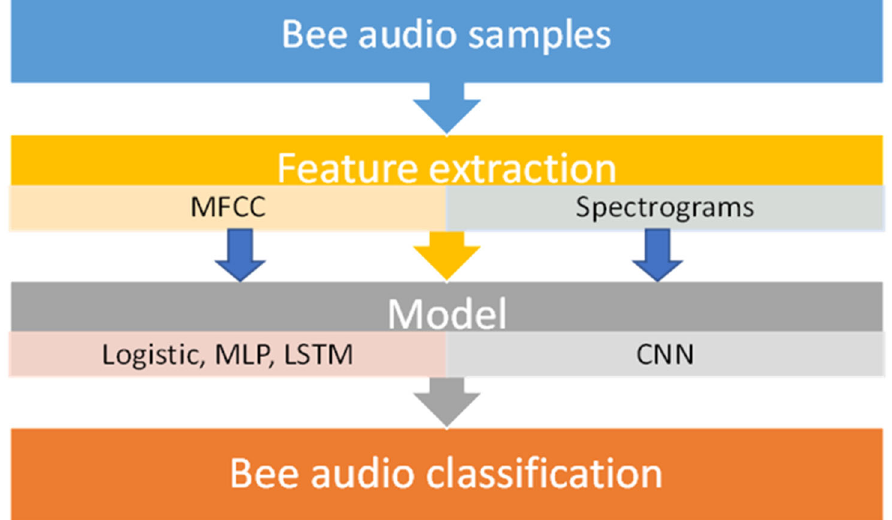
Figure 3. An overview of the classification pipeline.